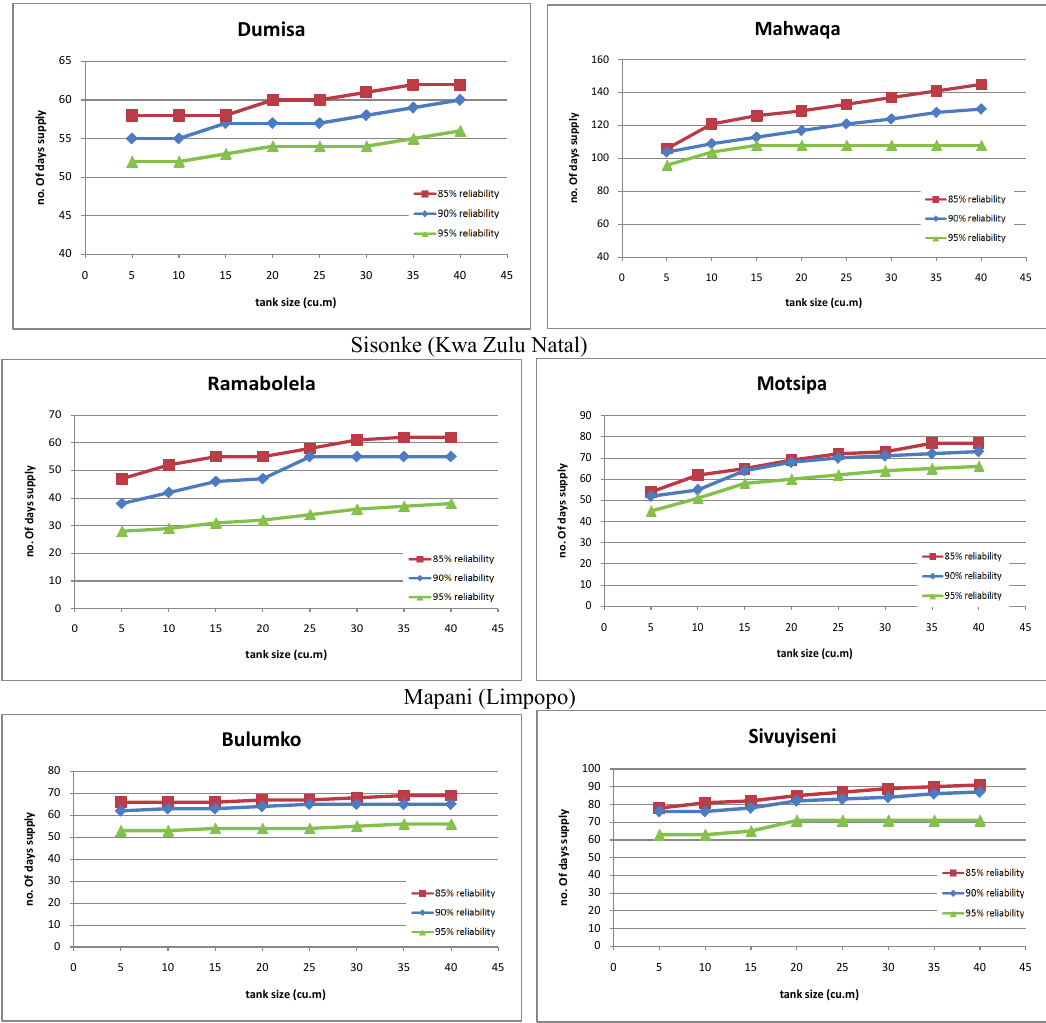
Fig. 3 Number of days supplied per year for various storage sizes and